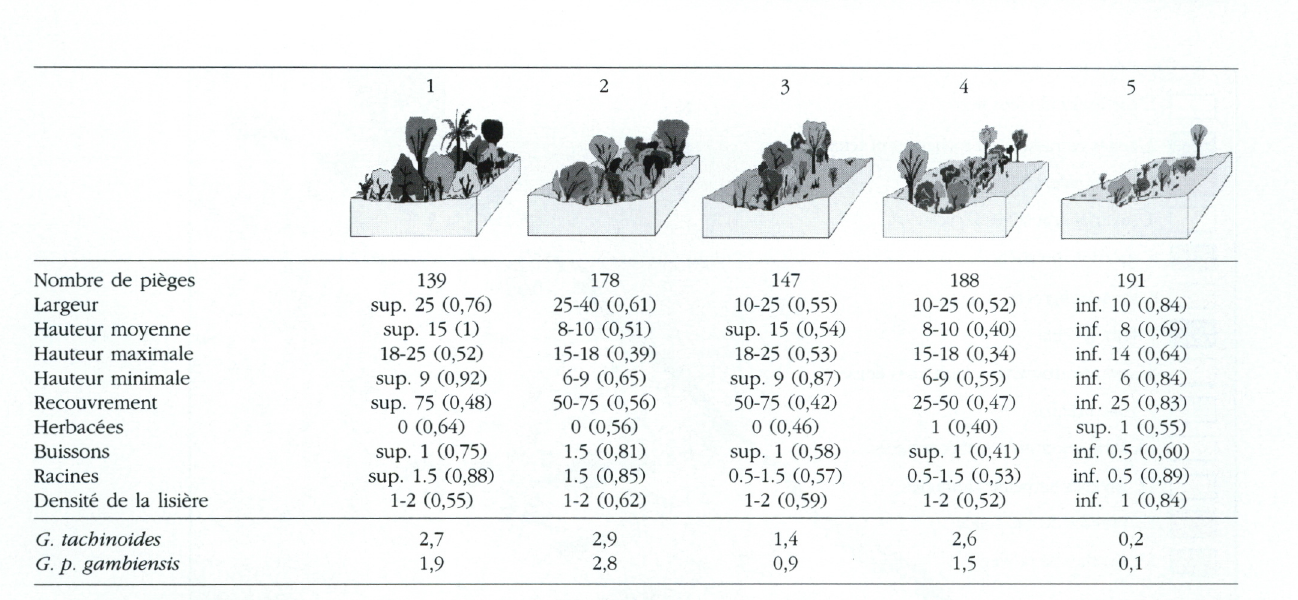
Fig. 13. - Architectures de formations végétales, principales modalités et densités de glossines correspondantes. Entre parenthèse sont indi­ qués les fréquences des modalités. Les largeurs et hauteurs sont en mètres. Le recouvrement est en pourcentage. Les grilles des indices